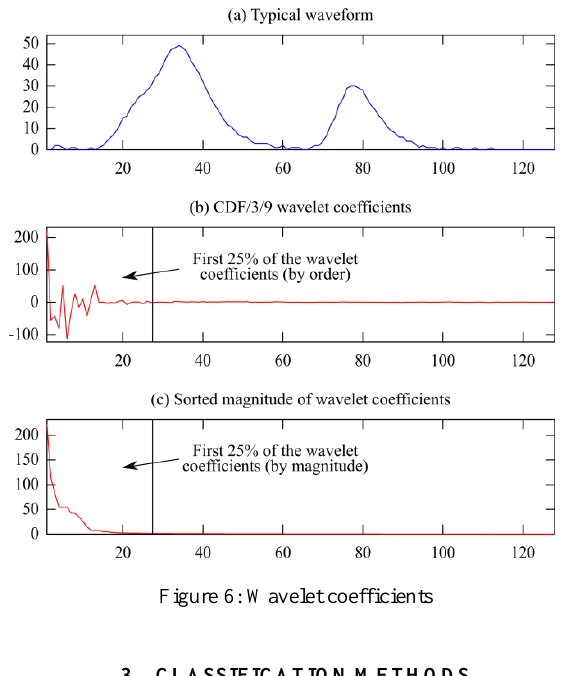
Figure 6: Wavelet coefficients